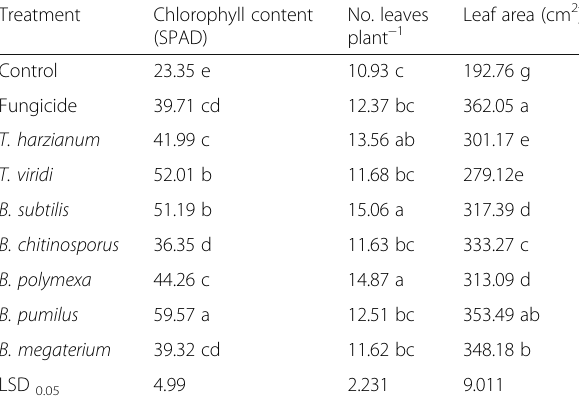
Table 3 Effect of bio-agent treatments on chlorophyll content and growth parameters of mildewed squash plants Treatment